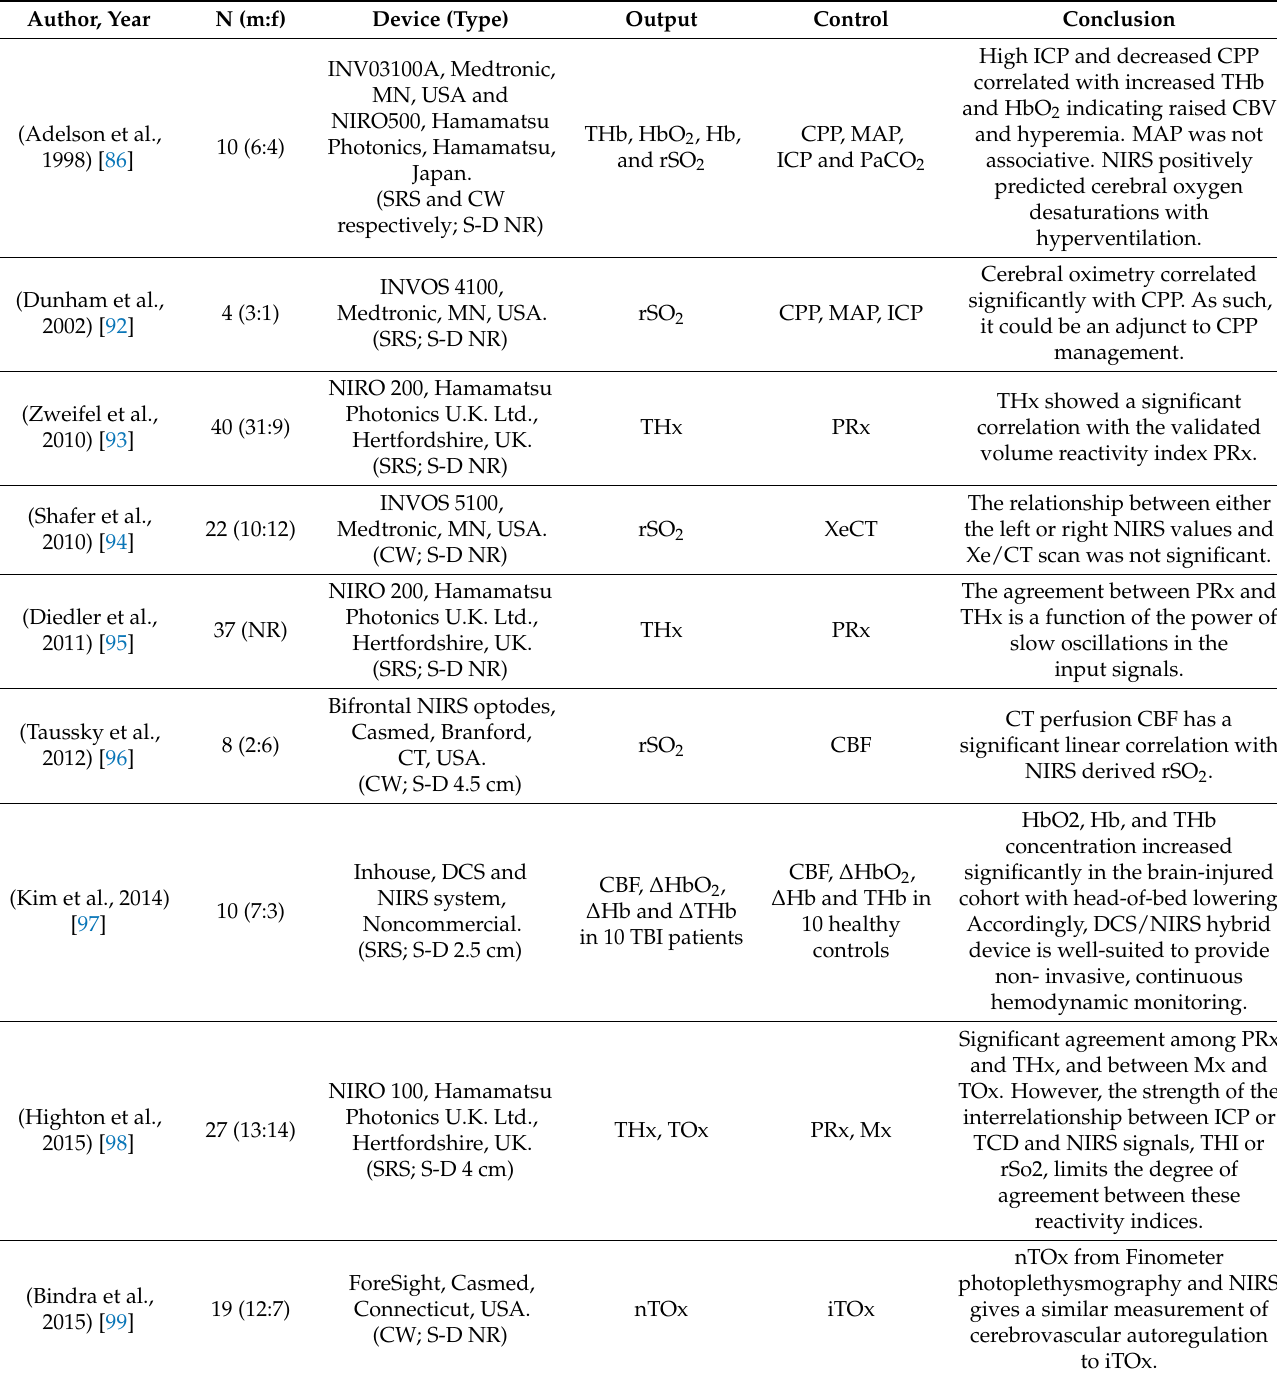
Table 2. Summary of the evidence on NIRS-derived autoregulation in